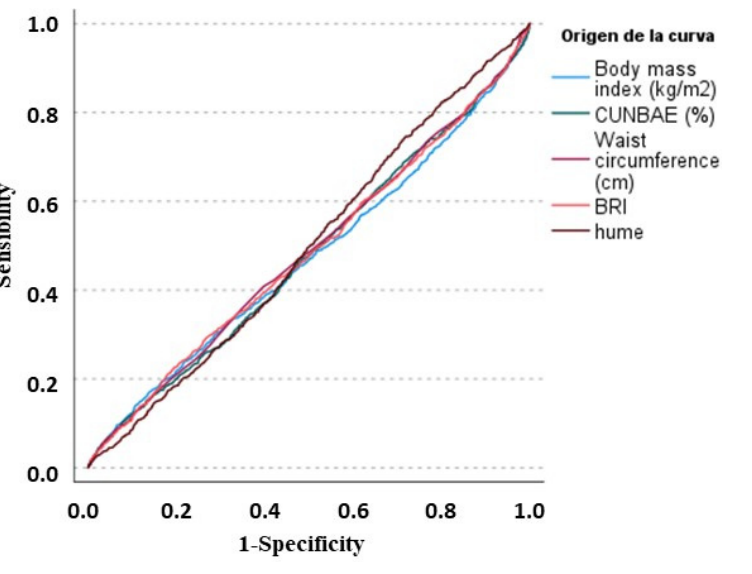
Figure 1. Receiver operating characteristic (ROC) curve analysis in the ILERVAS population to assess the diagnostic accuracy of obesity indices to identify patients with higher AGEs from those with normal AGEs. Table 3. Bivariate correlations of SAF with anthropometric formulas in the ILERVAS population.